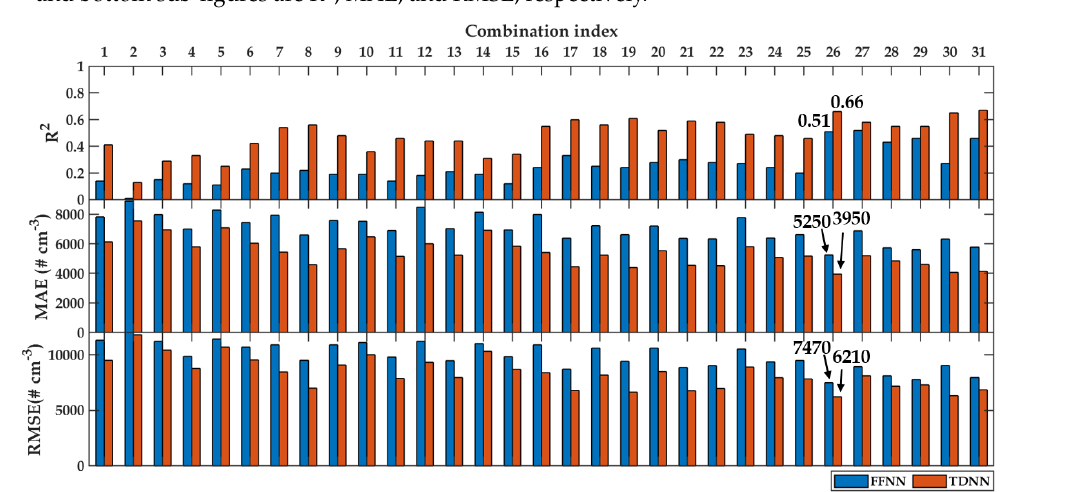
Figure 9. Performance metrics of hourly modeling using FFNN (blue) and TDNN (red). The top, middle, and bottom sub-figures are R 2 , MAE, and RMSE,